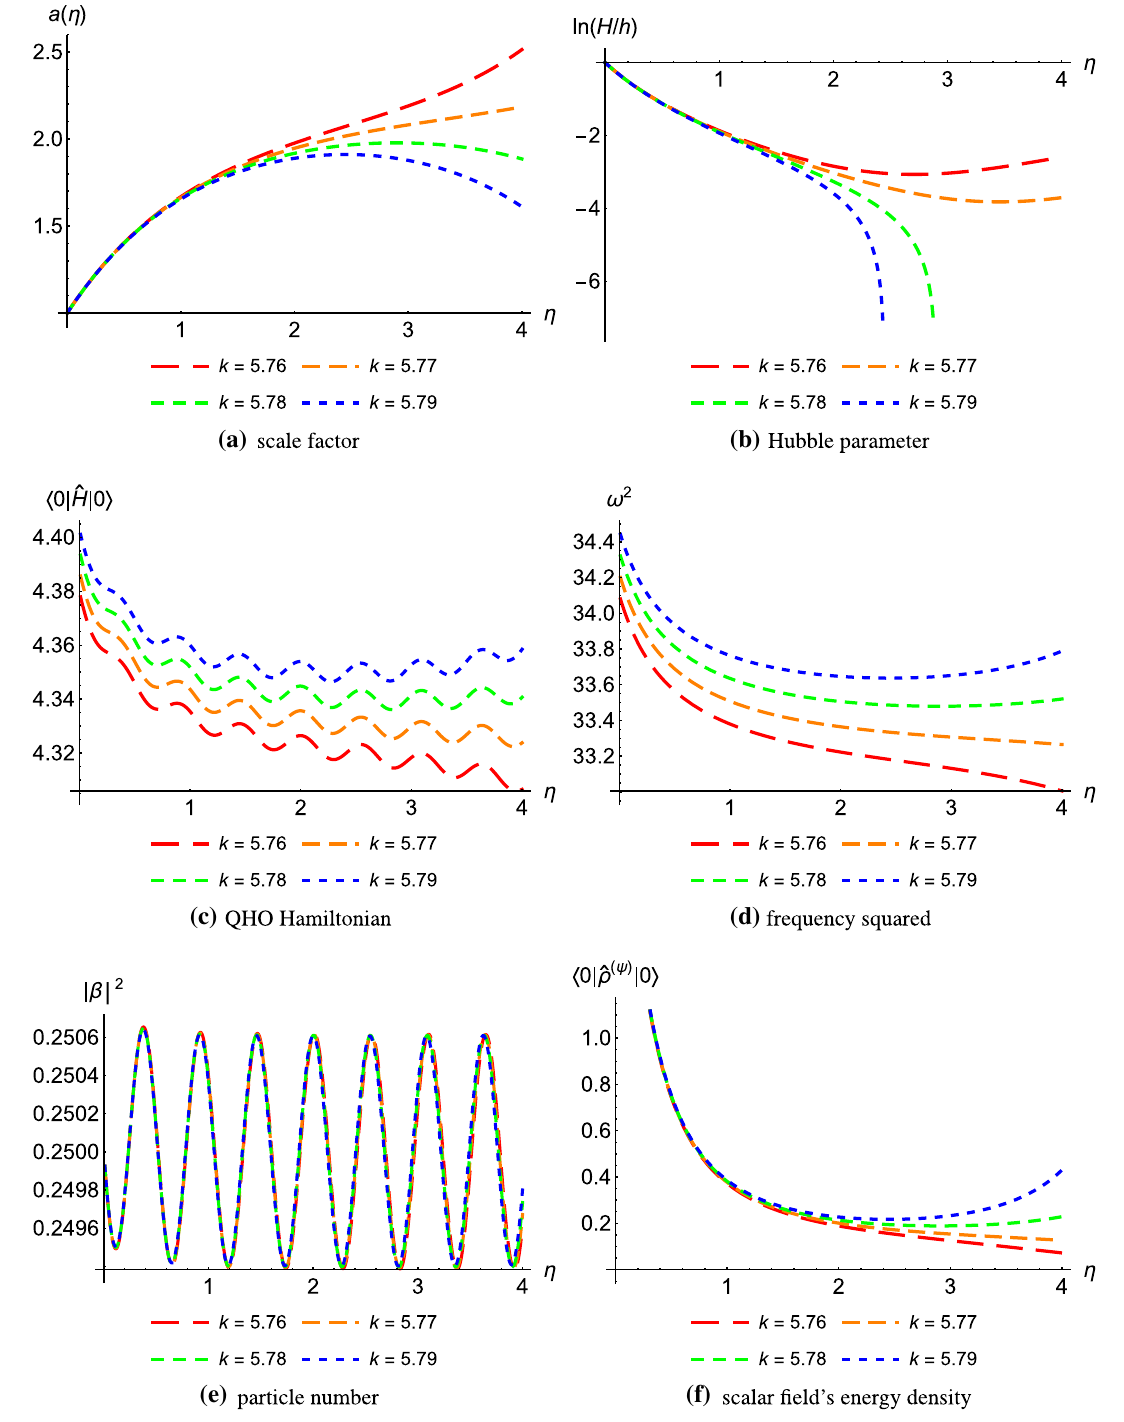
Fig. 3 Plots of a scale factor, a , b Hubble parameter, H = a (cid:8) / a 2 , c QHO Hamiltonian, (cid:4) 0 | ˆ H | 0 (cid:5) , d frequency squared, ω 2 , e particle number, | β | 2 , and f scalar field’s energy density, (cid:4) 0 | ˆ ρ (ψ) | 0 (cid:5) , obtained using the CQC for k = 5 . 76 , 5 . 77 , 5 . 78 , 5 . 79 with a 0 = 1 and h =